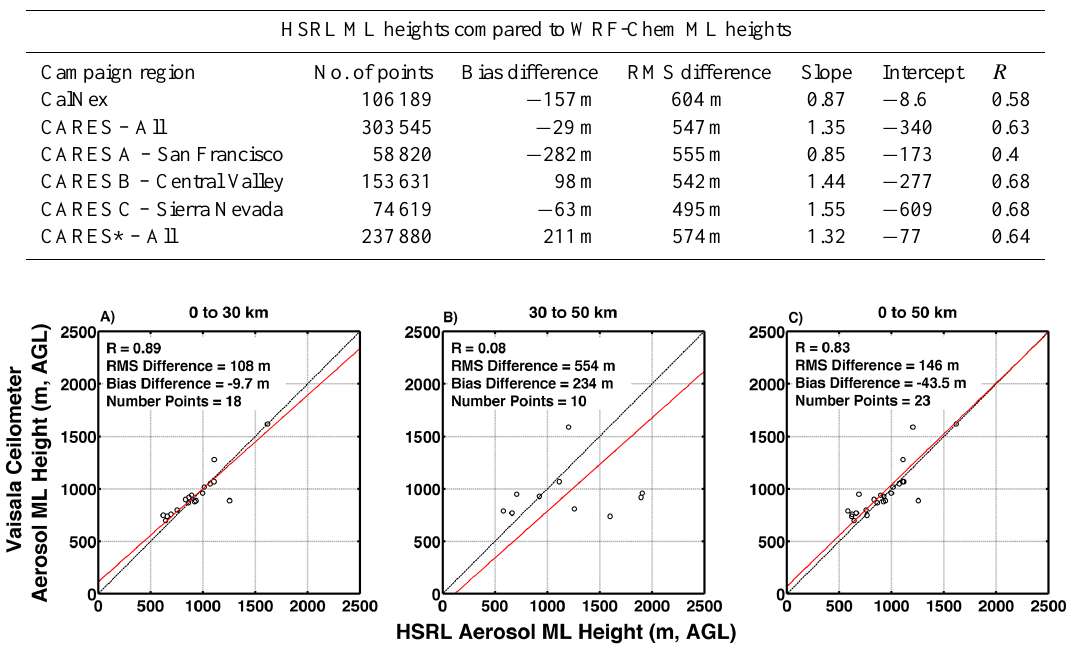
Figure 3. Scatter and bisector regression plots of HSRL and ceilometer aerosol ML heights as a function of distance of closest approach of the aircraft to the ceilometer. The circles compare the ceilometer measurement to the HSRL data taken at the point of closest approach to the Pasadena ground site. The comparison points in the plot on the far right (Fig. 4c) are further limited to only consider points where the HSRL location had similar ground altitude (within ± 200m) of the altitude of the Pasadena ground